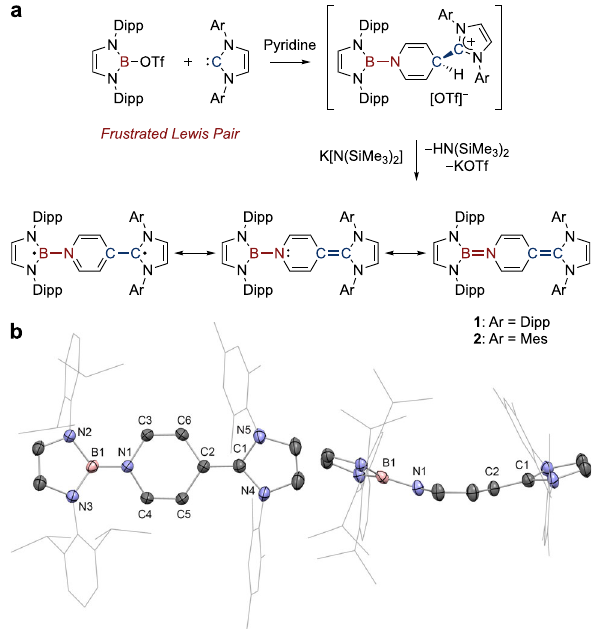
Fig. 3 Electrochemical studies. a Cyclic voltammogram of 1 ([ n Bu 4 N][PF 6 ] in CH 2 Cl 2 at 100 mV s − 1 ). b Redox ranges associated with related structurally characterized radicals (Hansmann et al. reported in ref. 12 that